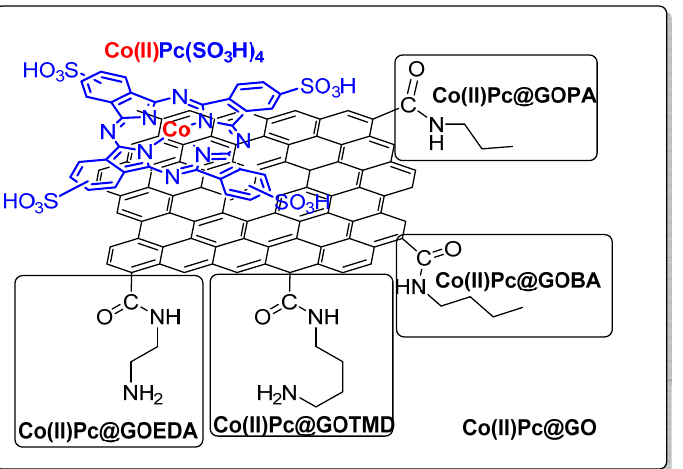
Figure 17. Schematic representation of Co(II) phthalocyanine Co(II)Pc(SO 3 H) 4 attached to graphene oxide ( GO ) functionalized with different amines: propylamine ( PA ), butylamine ( BA ), ethylenediamine ( EDA ) and tetramethylenediamine ( TMD ) (adapted from [65]). Considering the importance of developing alternatives to the drastic conditions used in Merox ® process (high pressure and temperature, presence of caustic soda), Omadoko and coworkers [66] found that Co(II) complex of the sodium salt of tetrasulfonated phthalocya- nine ( Co(II)Pc(SO 3 Na) 4 ) (Figure 18) is able to fully oxidize ethanethiol to diethyl disulfide, under base free conditions, in O 2 saturated dimethylformamide (DMF) after 10 min at 40 °C with a turnover number (TON) of 72 and turnover frequency (TOF) of 8.1 min − 1 .